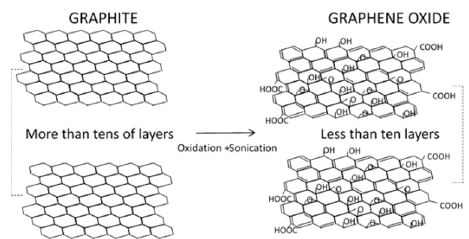
Figure 1. Structures of graphite (with more than ten layers) and graphene oxide (with fewer than ten layers).